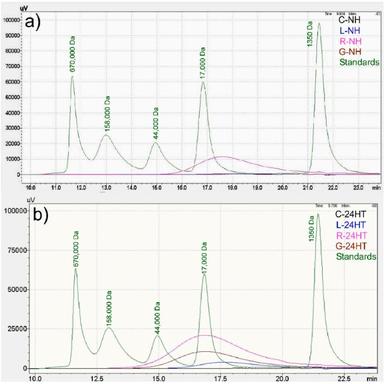
Size exclusion chromatogram of a) non-heated (NH) and b) 24h heat-treated (24HT) fish gelatin-based films as a function of saccharide (glucose (G), lactose (L), and ribose (R)) detected at 440 nm, while the standards were detected at 254 nm.